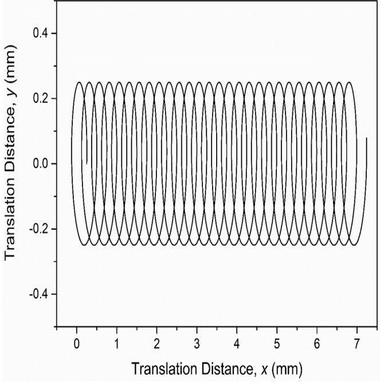
'Tidally locked' orbital toolpath (radius 0.25 mm, feed rate 0.34 mm/s, current 2000 mA).